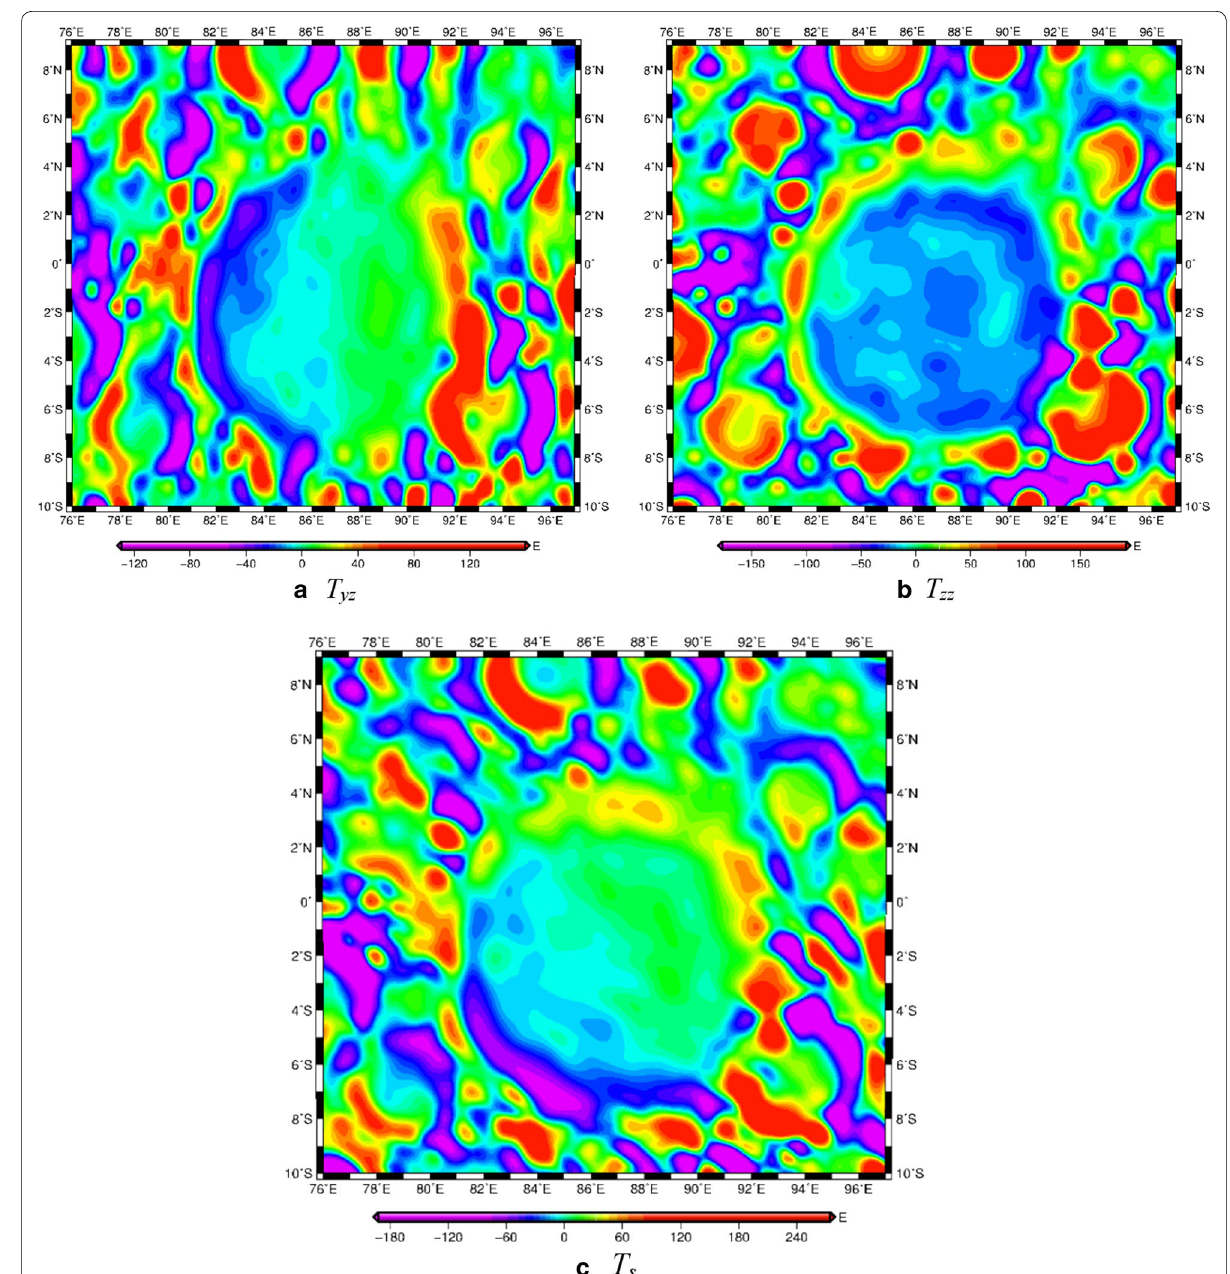
Fig. 15 Lunar GGT datasets derived from GL1500E, a and b are T yz and T zz components of the lunar GGT, respectively, and c T s is the summation of T xx , T xy , T xz , T yy , T yz and T